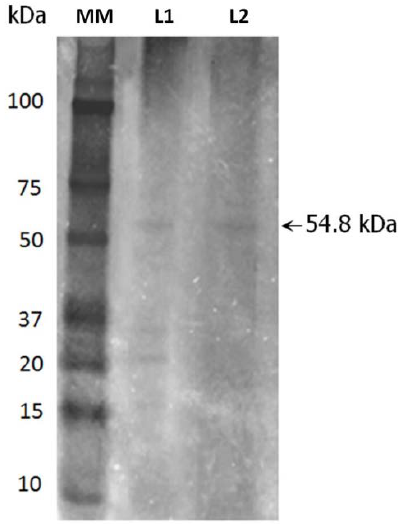
Figure 1. SDS-PAGE profile of α-amylase purified from R. oryzae FSIS4: Lane MM, molecular marker; Lane L1, dialyzed crude extract; Lane L2, purified α-amylase (interfacial phase) with an apparent molecular mass of 54.8 kDa.